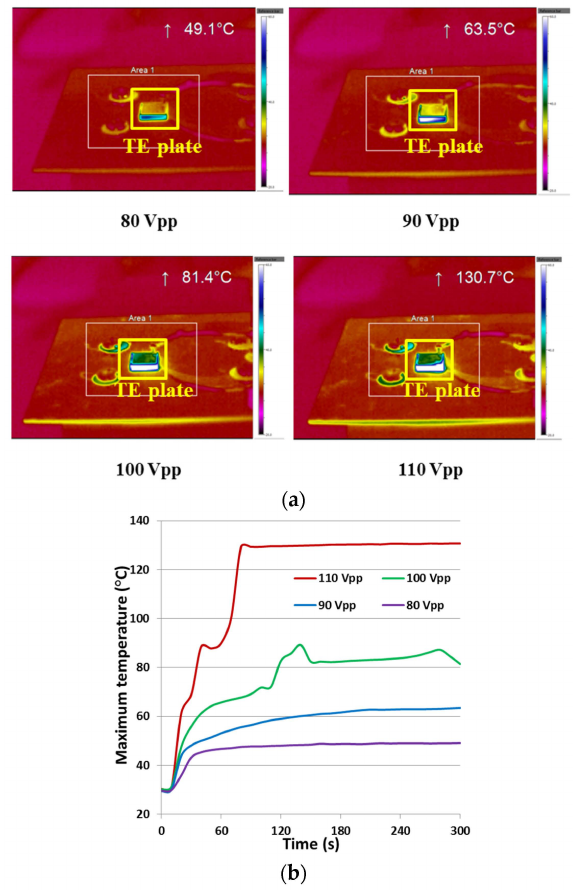
Figure 8. ( a ) Thermal mapping and ( b ) Maximum spot temperature of a PMN-PT TE plate driven with different voltages for 5